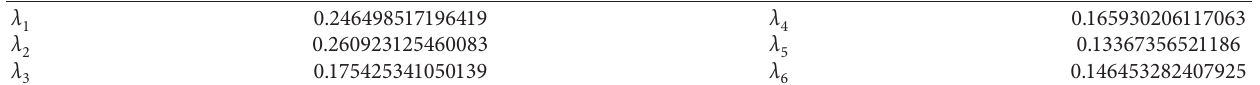
Table 3: The parameters of the DBGM (1, N) model in case